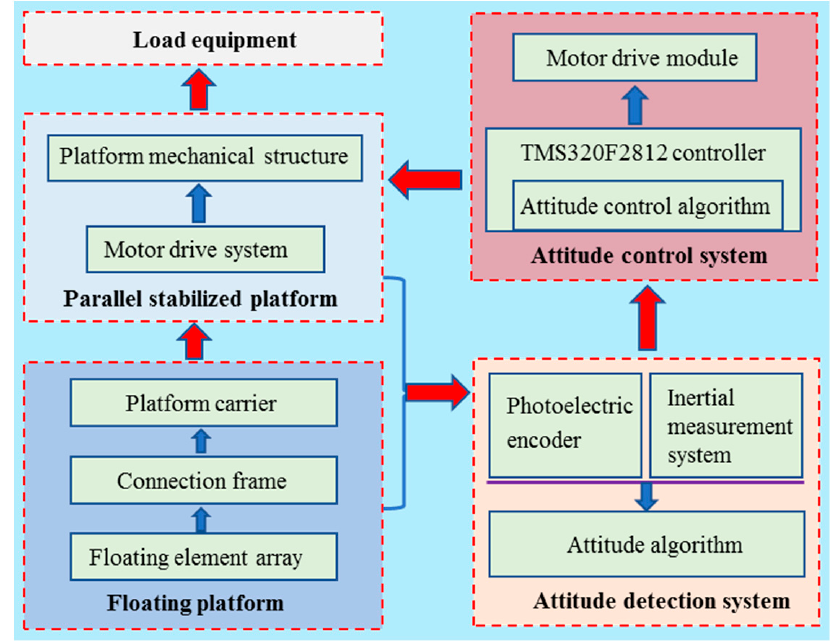
Figure 6. Working flow diagram of the attitude stabilization system.